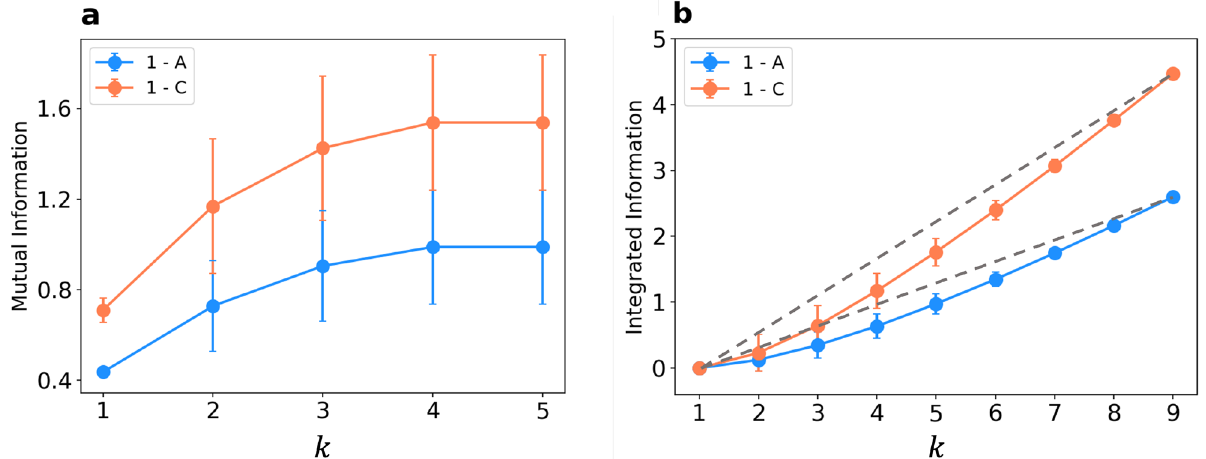
Figure 5. ( a ) experimental MI ( k ) for two different electrode couples to which (cid:31) V = 1 V is applied (1-A: azure and 1-C: orange). Data are collected over 275 distinct configurations. ( b ) IN ( k ) for the same experimental data. Data are collected over 275 distinct configurations. In both cases, errorbars are given by the evaluation of these observables over all the different ways of choosing a given k . MI is only measured up to k = 5 , since growth in a fully correlated system.